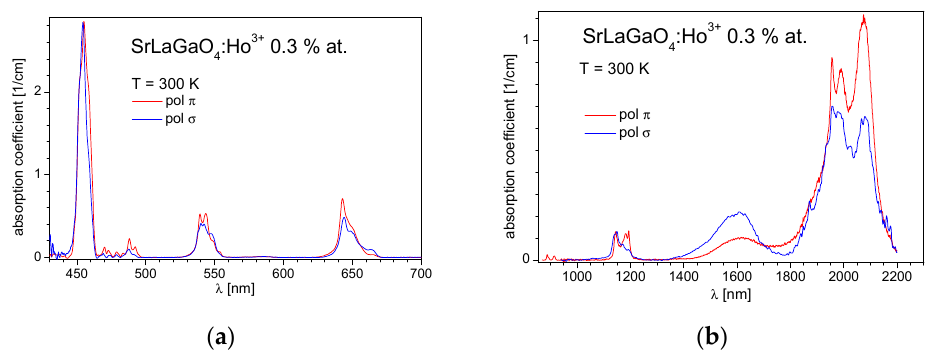
Figure 3. ( a ) Visible and ( b ) Infrared part of the polarized absorption spectrum of SrLaGaO 4 :Ho 3+ crystal recorded at room temperature.